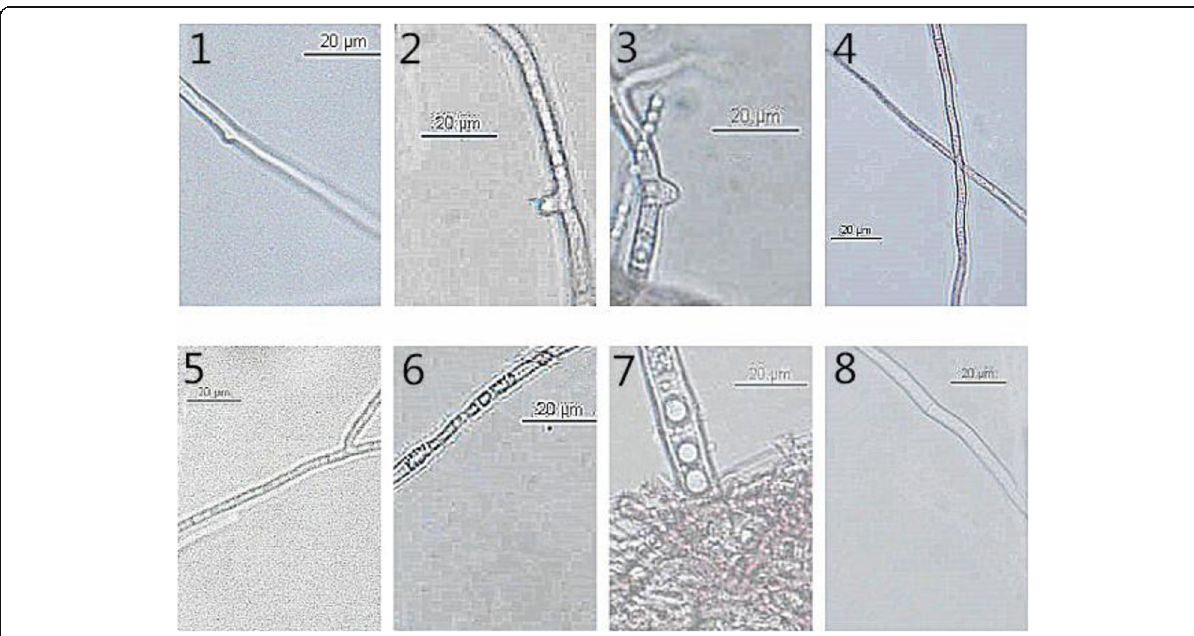
Fig. 3 Effect of extracellular culture supernatant of BM21 on mycelium of F. graminearum (magnified × 400). 4 and 8 were non-treated control; 1 and 5 , 2 and 6 , and 3 and 7 indicate coarser hyphae and cytoplasmic granulation becoming more and more serious with the increase of concentration of extracellular culture supernatant (1%, 5%, and 10%),